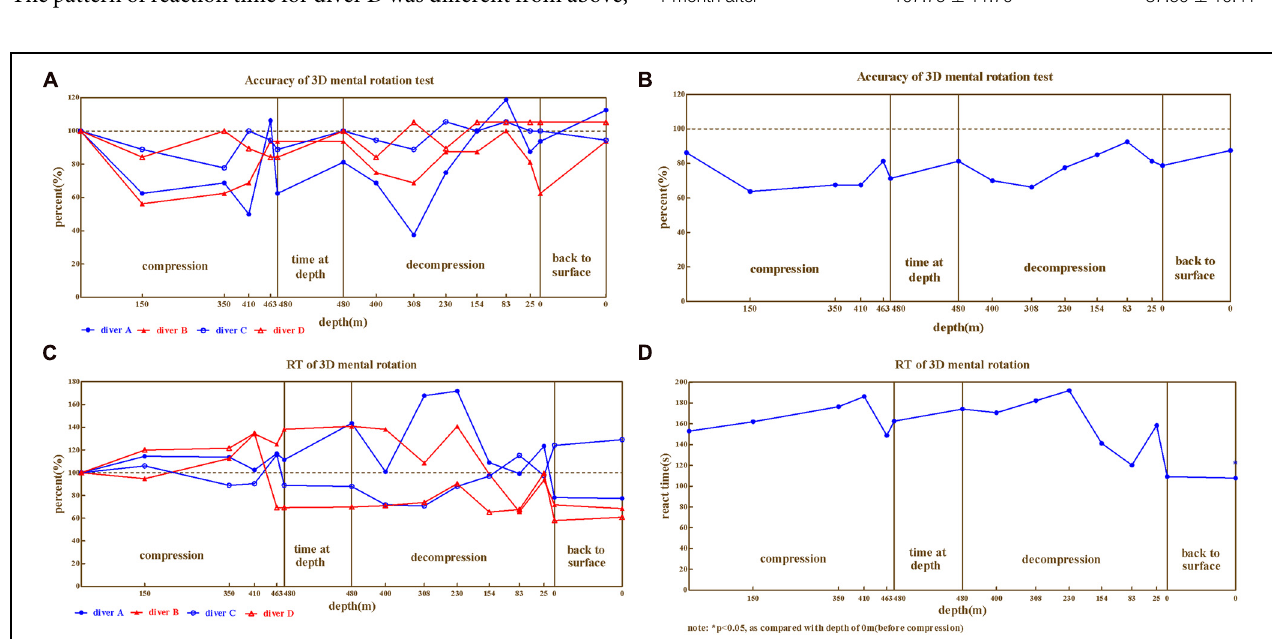
FIGURE 3 | The results from 3D mental rotation. (A) Correct rate for four divers, (B) Correct rate on Average, (C) Reaction time for four divers, (D) Reaction time on average.